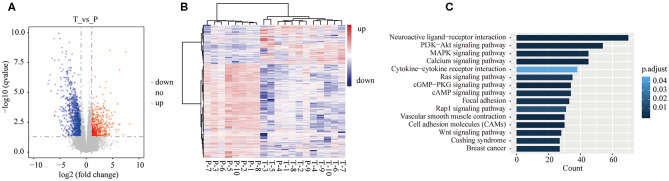
Differentially expressed genes (DEGs) in tumor tissues were compared with para-tumor tissues of 10 GBC patients. (A) Volcano plot of the differential expression analysis of genes. (B) Heatmap of unsupervised hierarchical clustering of DEGs in all samples of GBC patients. (C) The top 15 pathways of DEGs of GBC were identified by KEGG enrichment.